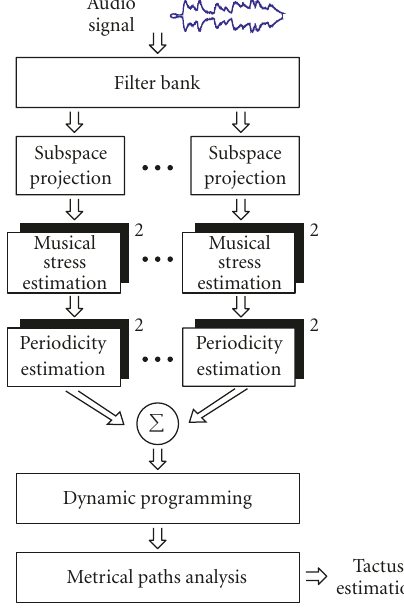
Figure 2: Overview of the tempo estimation